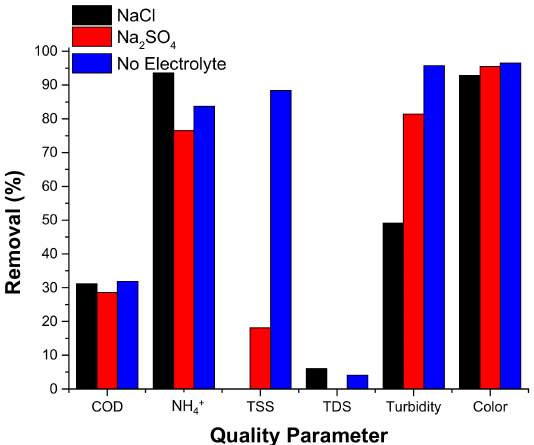
Figure 6. Removal rate of COD, NH 4+ , TDS, TSS, turbidity, and color without electrolyte, with sodium chloride (NaCl), or sodium sulfate (Na 2 SO 4 ) (pH = 7.5; current density = 64 mA/cm 2 ; electrolysis time = 120 min; temperature = 20 ◦ C).